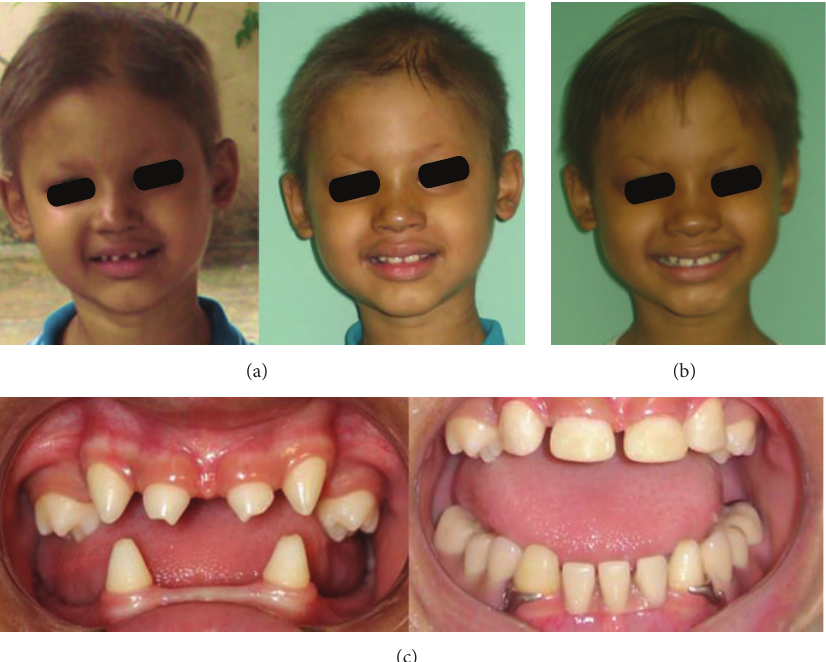
Figure 4: Patient before and after treatment. (a) Initial and final facial aspect. (b) 12 months after the installation of the prosthesis. (c) Oral